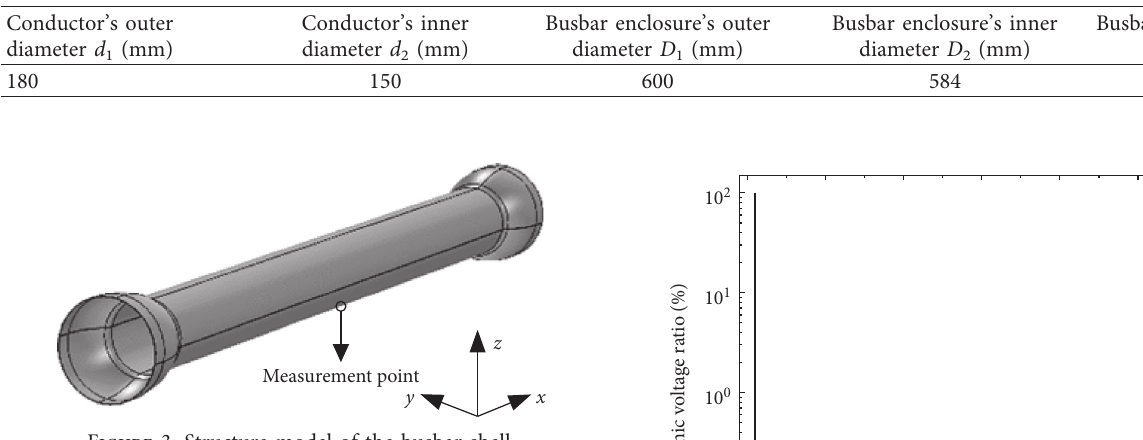
Figure 3: Structure model of the busbar shell.